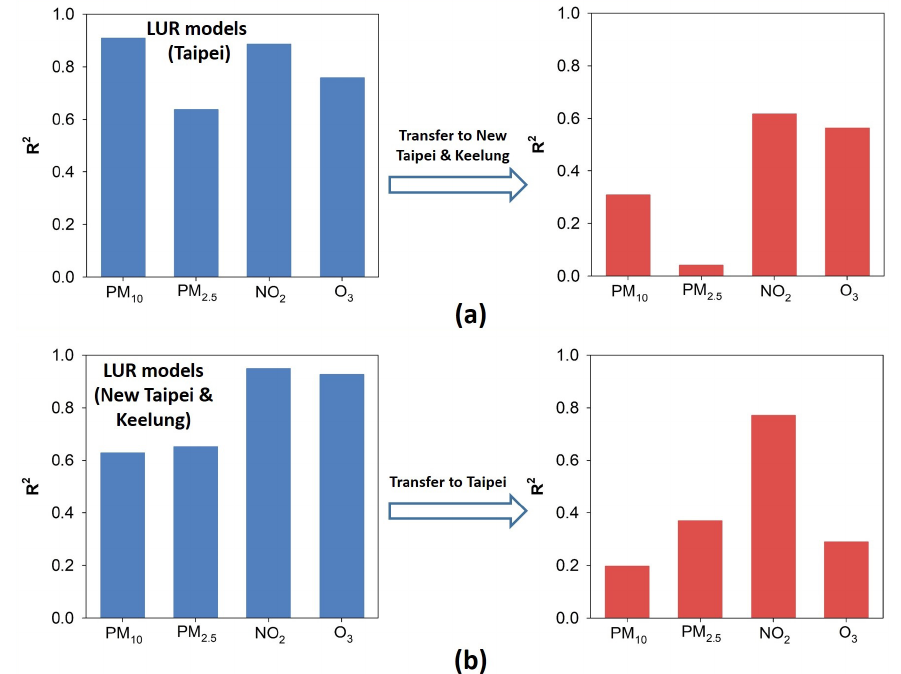
Figure 3. The changes in R 2 values for direct transfer of ambient PM 10 , PM 2 . 5 , NO 2 and O 3 LUR models between Taipei City and New Taipei City and Keelung City.